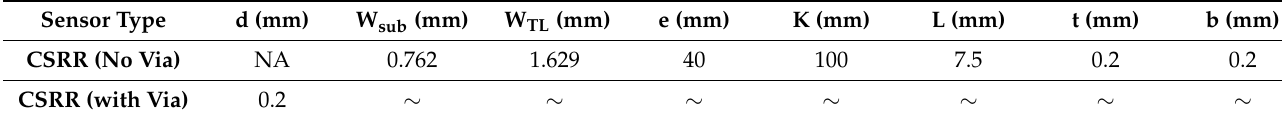
Table 1. Design specification of the sensors.